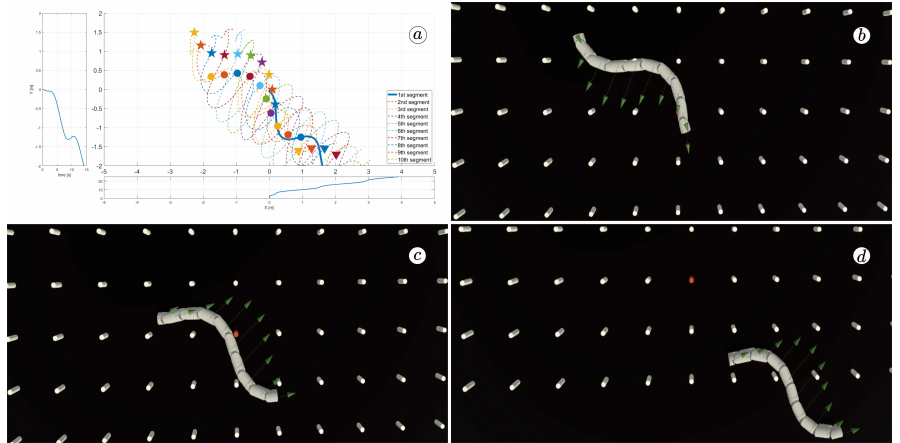
Figure 35. Trajectories of robot segments for φ i ,ref = 50 ◦ sin ( 50 ◦ t + ( i − 1 ) 40 ◦ ) ( a ) and robot configu- rations for t = 5 ( s ) ( b ), t = 10 ( s ) ( c ), and t = 24 ( s ) ( d